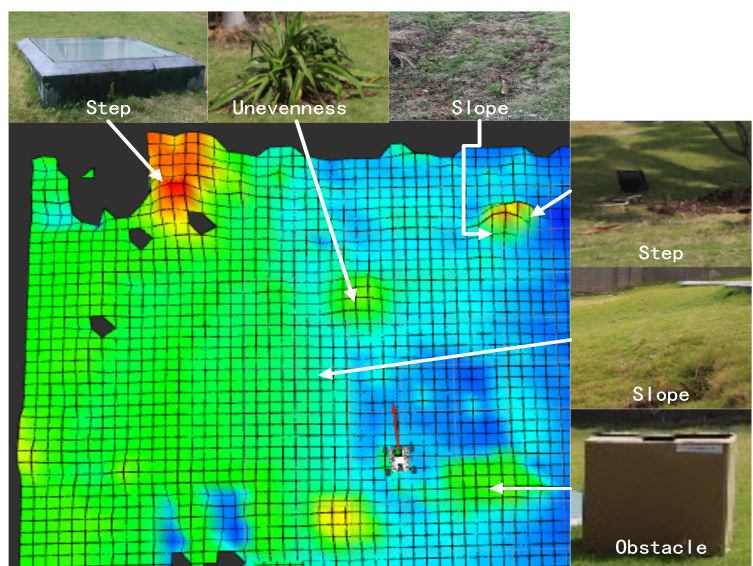
Figure 5. DEM of the experimental uneven terrain.